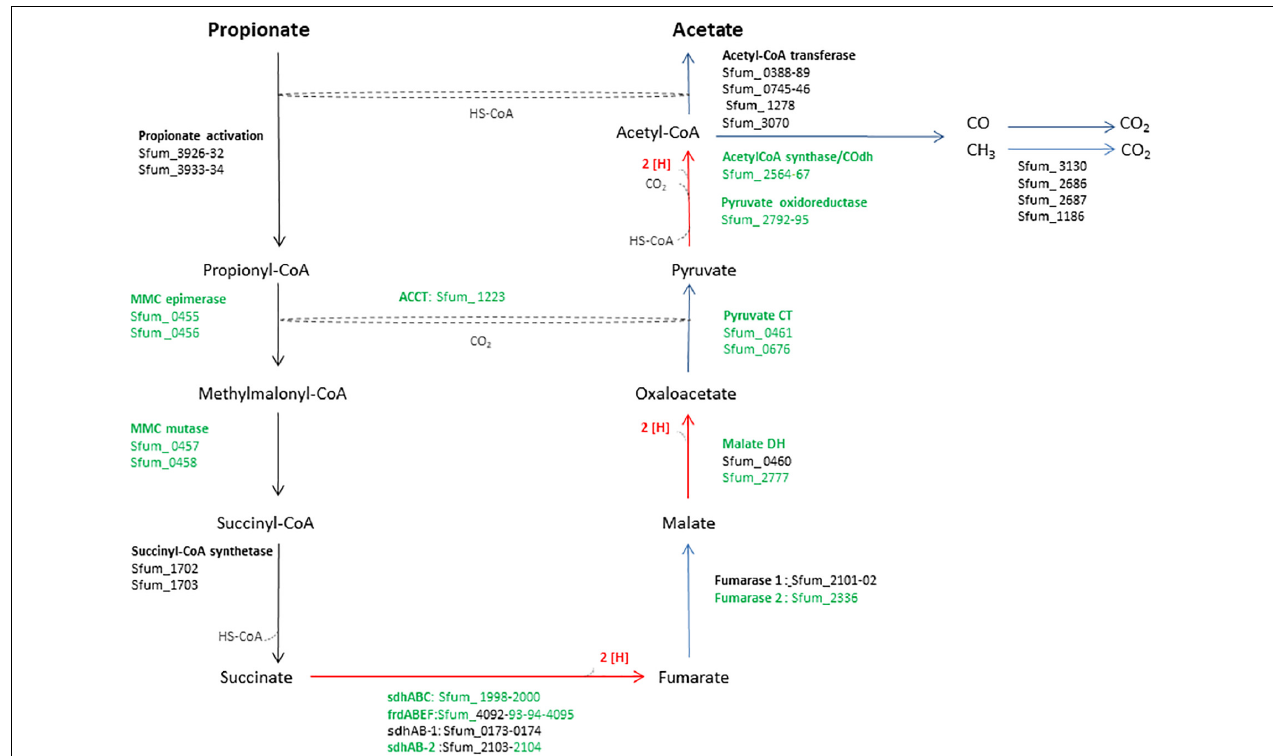
FIGURE 1 | An overview of enzymes and pathway of the methylmalonyl-CoA pathway of SF. The enzymes in green were used in the heatmap in Figure 3 . MMC, methylmalonyl-CoA; Sdh, succinate dehydrogenase; Frd, fumarate reductase; DH, dehydrogenase; CT, carboxyltransferase; ACCT, acetyl-CoA carboxyltransferase; CoA Trans, coenzyme A